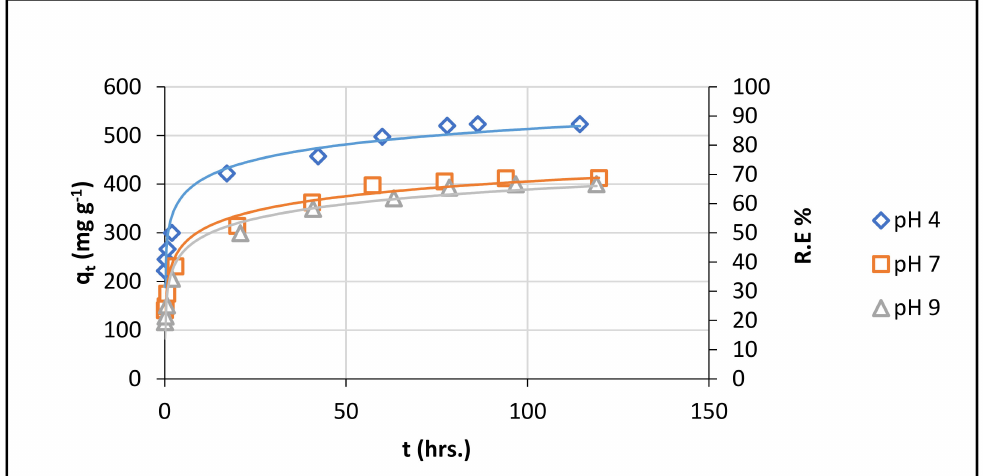
Figure 5. Effect of pH on CR dye adsorption onto UCs (Experimental conditions: 50 mg of adsorbent, 50 mL of dye solution (600 mg L − 1 ) and temperature 55 ◦